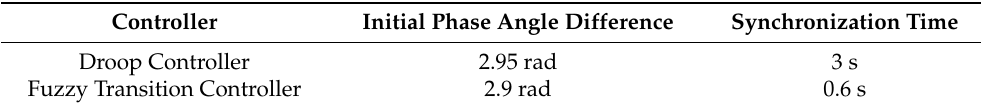
Table 3. Comparison between droop and fuzzy characteristics for grid synchronization conditions.